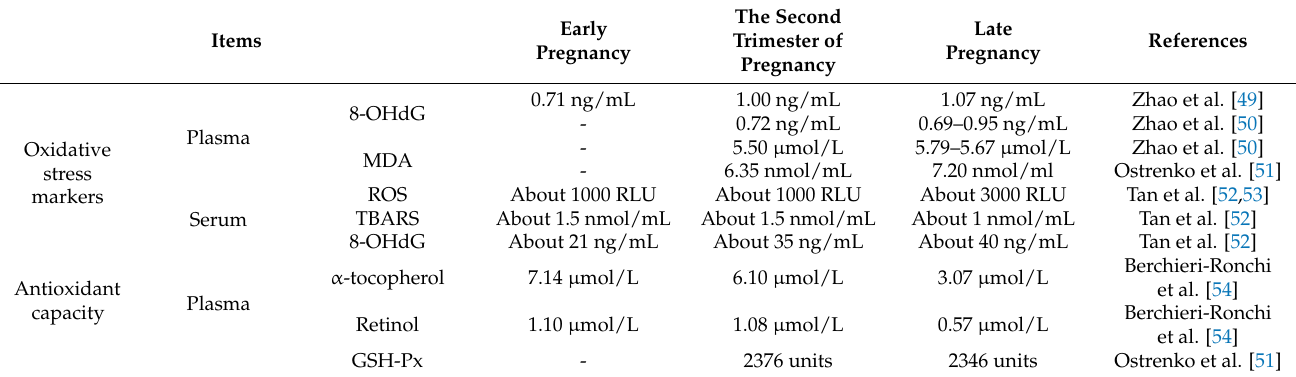
Table 1. Oxidative stress markers of sows at different pregnancy